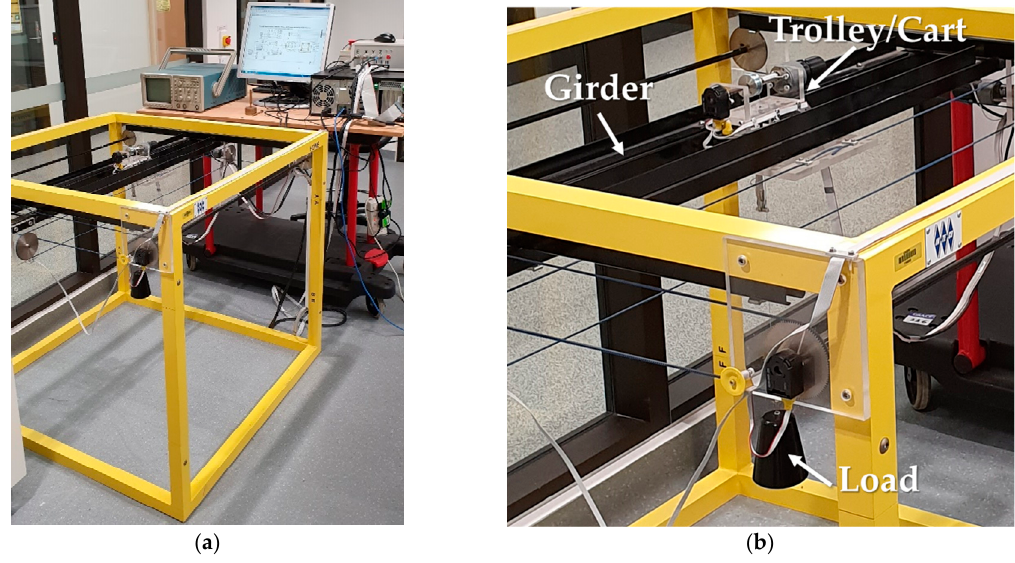
Figure 7. ( a ) The experimental overhead crane setup used in this study; ( b ) Zoomed-in view.